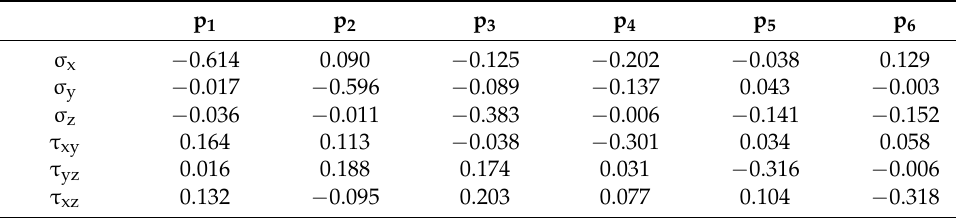
Table 3. Calibration matrix obtained by inverting the matrix S reported in Table